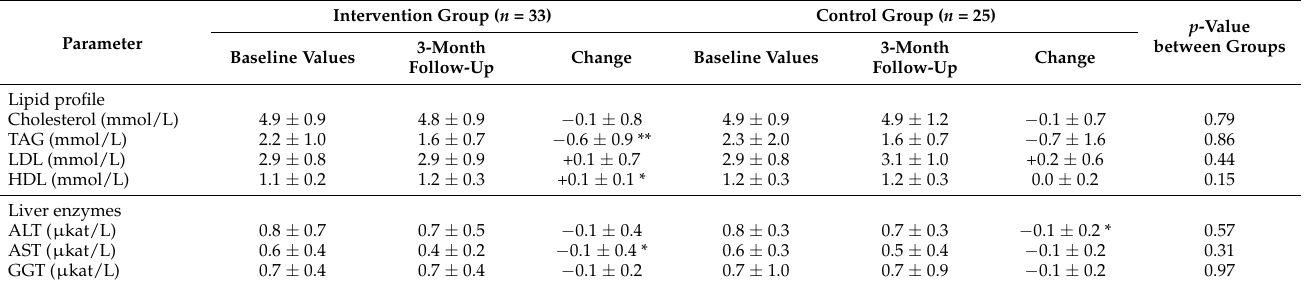
Table 6. Change in lipid parameters and liver enzymes in 3-month complete